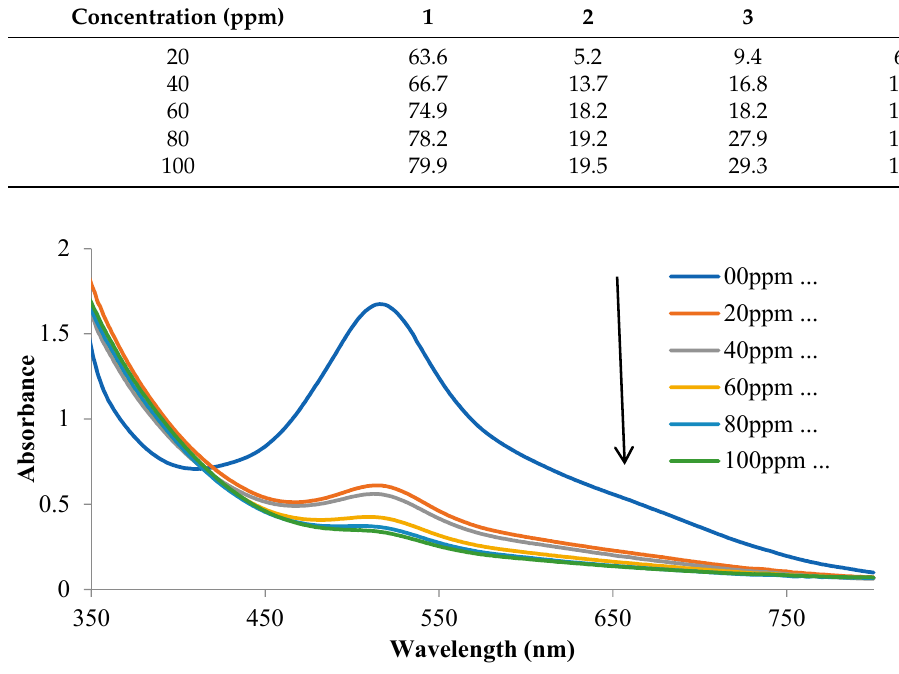
Figure 4. Absorption spectra of DPPH in the absence (top spectra) and presence of the compound 1 (20, 40, 60, 80, and 100 ppm). There is abrupt drop in the absorbance of the solution by addition of the antioxidant agent (compound 1 ).